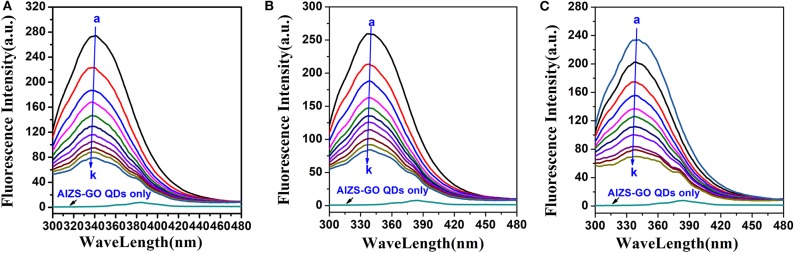
Influence of AIZS-GO QDs on HAS fluorescence intensity at diverse temperatures. (A) 298 K, (B) 303 K, (C) 308 K. c(HSA) = 1.0 × 10−6molL−1, c(AIZS-GO QDs): (a-k): 0, 1, 2, 3, 4, 5, 6, 7, 8, 9, 10 × 10−6molL−1 pH = 7.4, λex = 285 nm.